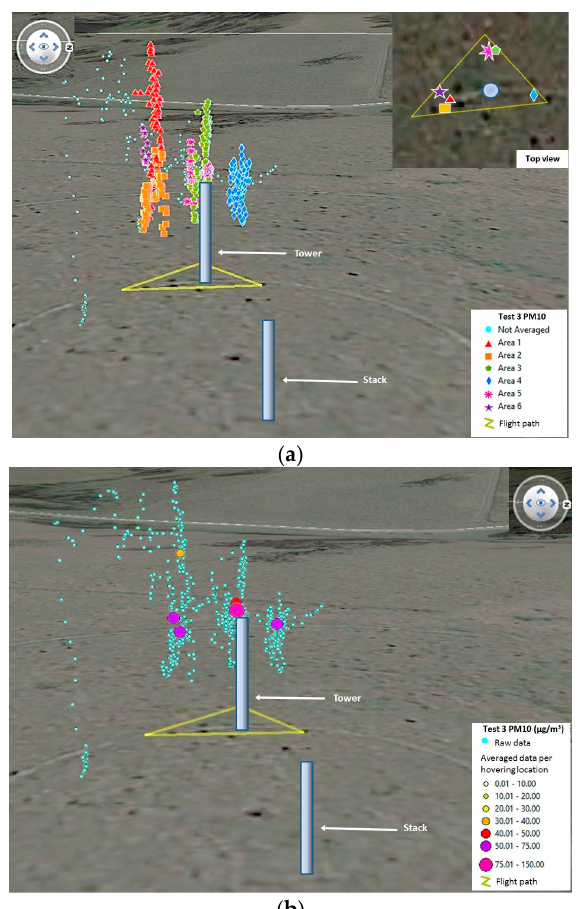
Figure 20. 3D visualization for Test 3, showing ( a ) the waypoints grouped per high density areas, and ( b ) the raw data and waypoints used once averaged per area.